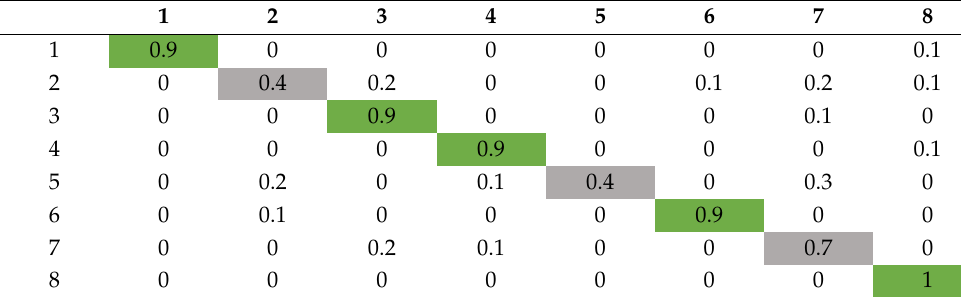
Table 7. The eight-subject confusion matrix for the practical testing